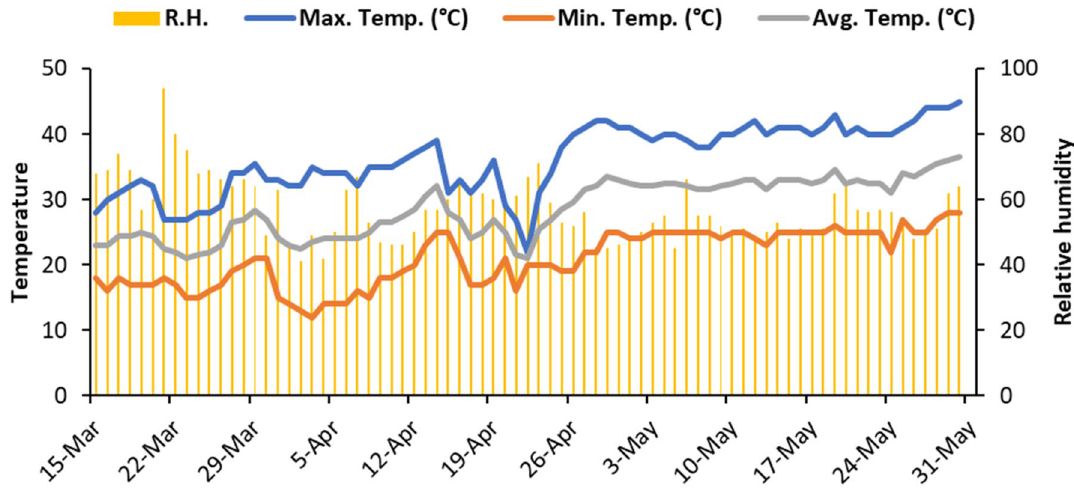
Figure 7. Weather conditions during the experiment 61